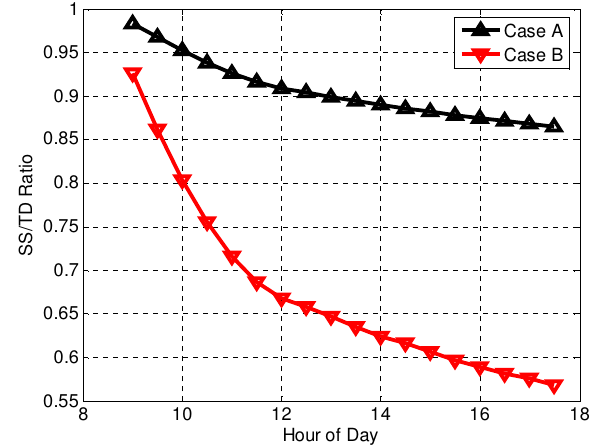
Fig. 2. Ratio of results from steady-state (SS) to time-dependent (TD) model for predicting the ratio of APN A /APN B for the two dif- ferent cases of oVOC behavior described in the text and illustrated in Fig.